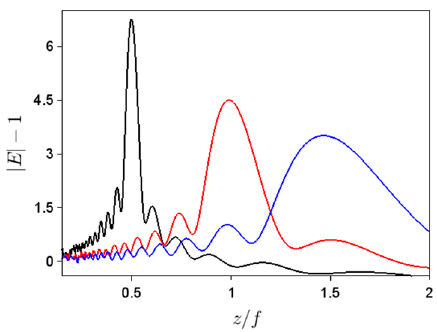
Figure 5. Dependence on z of the modulus of the electric field for ∆ φ m = 10°, N /2 = 700, and focal length f /2 (black line), f (red line) and 1.5 f = (blue line). length f /2 (black line), f (red line) and 1.5 f = (blue